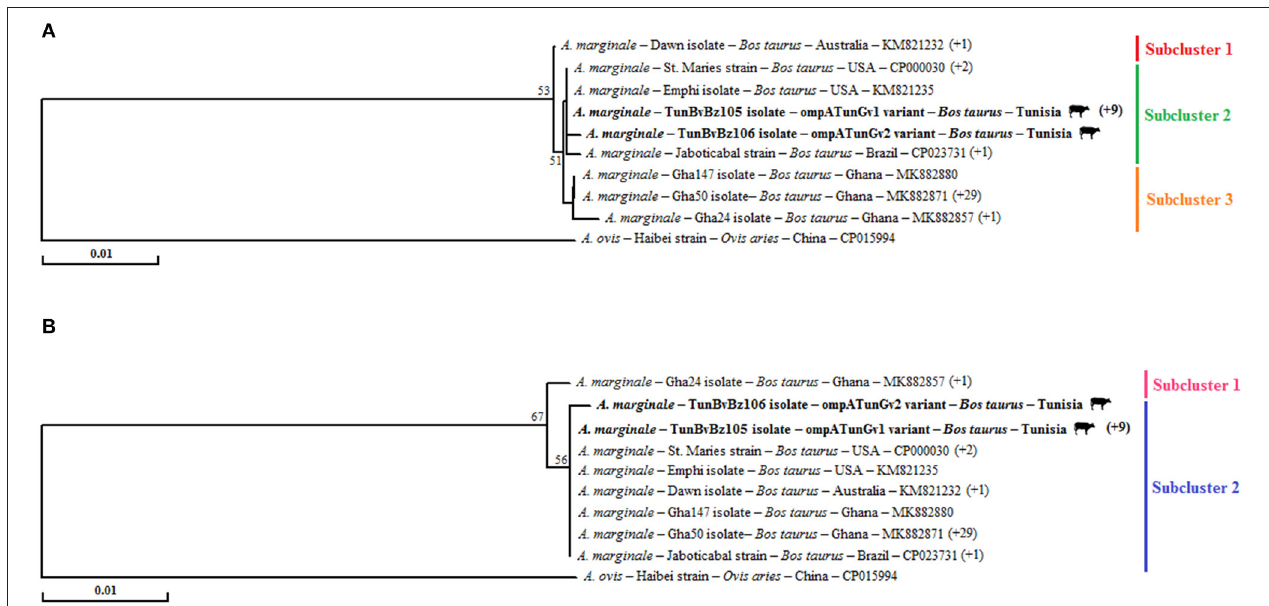
FIGURE 3 | Phylogenetic analysis of all available genetic variants of Anaplasma marginale based on the multiple alignment of partial nucleotide sequences (679 bp) of ompA gene (A) and their deduced amino acid sequences (236 AA) of the OmpA protein (B) using the “neighbor-joining” method. The numbers related to the nodes represent the robustness rates over 1,000 iterations (only the rates > 50% are represented). The host, strain or isolate, country of origin, and GenBank accession number are listed. The sequences of A. marginale newly obtained in this study are in bold and marked with a bovine picture. The numbers that are in parentheses at the end of some sequences represent isolates or strains that are represented by an identical sequence from the isolate or strain present in the tree.